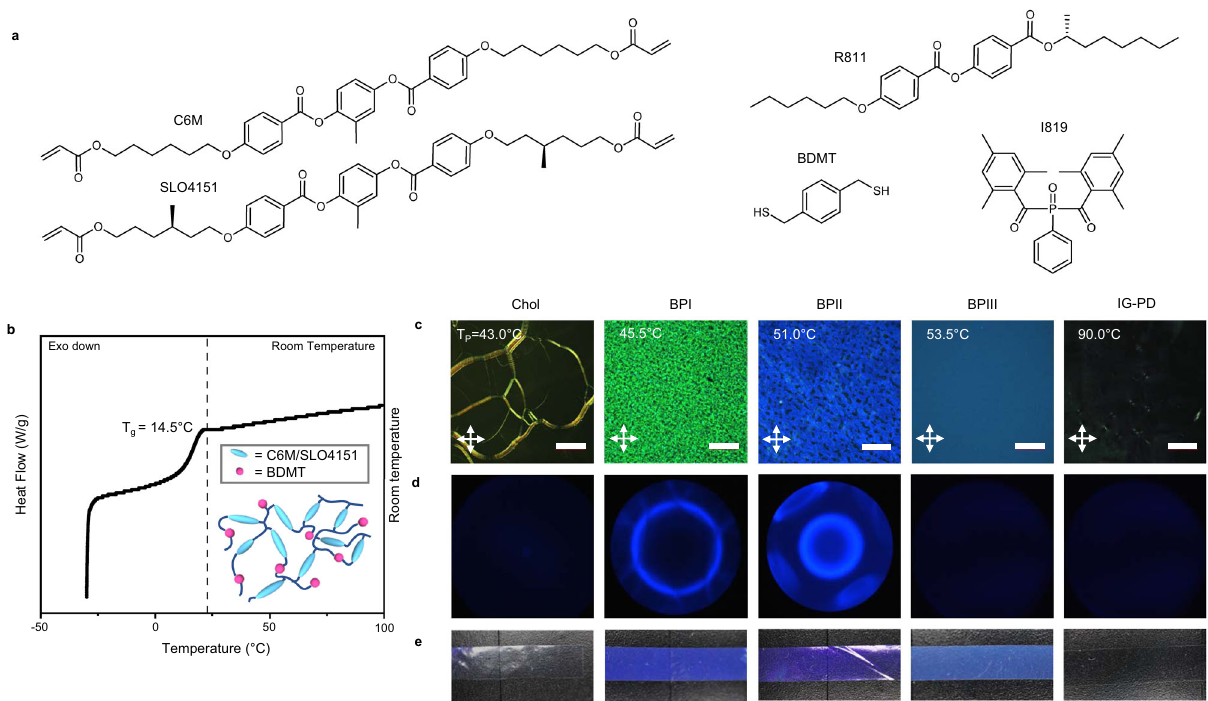
Fig. 1 Blue-Phase LCE formulation and phase retention. a Chemical structures of monomers. b DSC thermogram illustrating glass transition of the polymer network, independent of the phase retained. Inset) the LCE forms a hyperbranched polymer network. c Polarized optical micrograph textures (in re fl ection mode) of the LCE. Scale bars are 100 μ m. Images are captured at room temperature after each phase is retained via photopolymerized at the polymerization temperature (TP). From left to right: cholesteric phase (Chol), blue phase I (BPI), blue phase II (BPII), blue phase III (BPIII), and isotropic genesis polydomain nematic (IG-PD). d Kossel diagram (440nm) of free-standing elastomers retaining the stated phase con fi rming cubic structures for blue phase I (body-centered cubic [110]) and blue phase II (simple cubic [100]). e Photographs of LCE retaining either Chol, BPI, BPII, BPIII, or IG-PD phase, unpolarized